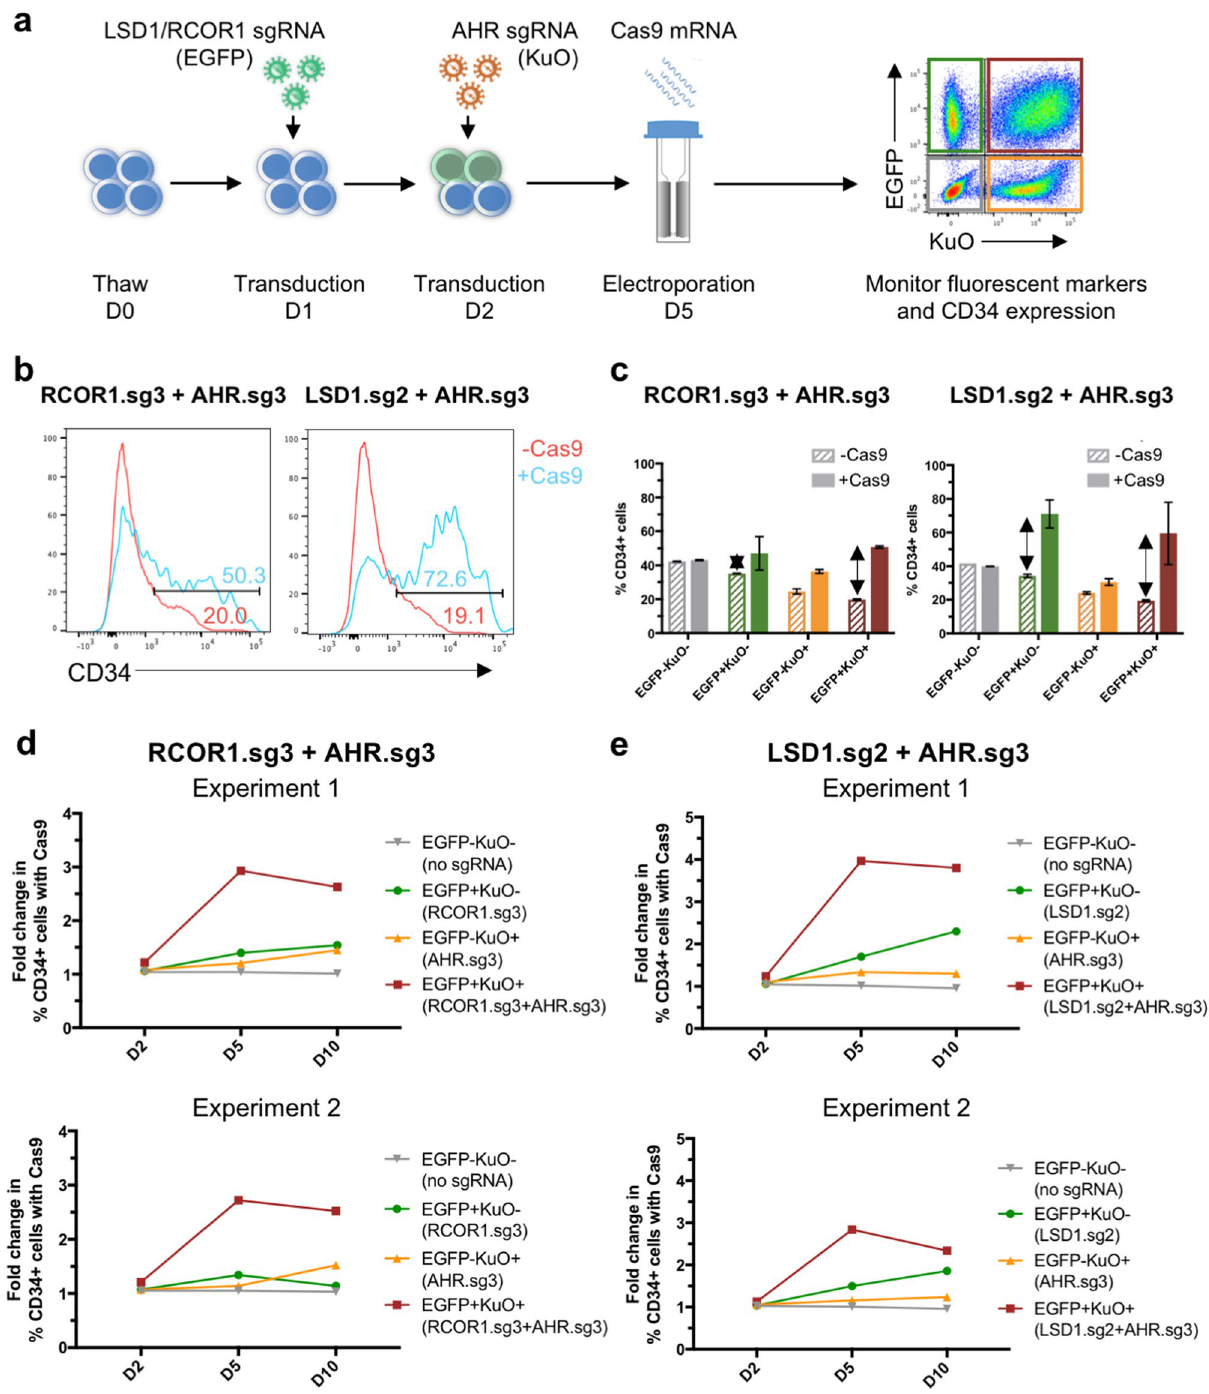
Figure 3. Combinatorial targeting of CoREST and AHR to propagate HSPCs ex vivo. ( a ) Schematic overview of experimental outline targeting LSD1 or RCOR1 and AHR. Thawed CD34 + cells were sequentially transduced on day 1 and day 2 with lentiviral sgRNAs targeting LSD1 or RCOR1 and AHR, containing EGFP or KuO, respectively. Cells were electroporated with Cas9 mRNA after 3 days in culture. Fluorescent marker and CD34 expression were monitored using flow cytometry. ( b ) Representative histograms showing the frequency of CD34 + cells in the double transduced (EGFP + KuO + ) population without (− Cas9) or with electroporation of Cas9 mRNA (+ Cas9) for sgRNA combinations RCOR1.sg3 and AHR.sg3, and LSD1.sg2 and AHR.sg3 at day 10 post-electroporation. ( c ) Frequency of CD34 + cells in the transduced populations using sgRNA combinations RCOR1.sg3 and AHR.sg3, and LSD1.sg2 and AHR.sg3, without (− Cas9) or with electroporation of Cas9 mRNA (+ Cas9) at day 10 post-electroporation. ( d , e ) The fold change in frequency of CD34 + cells with electroporation of Cas9 mRNA compared to only transduced cells (− Cas9) for sgRNA combinations RCOR1.sg3 and AHR.sg3, and LSD1.sg2 and AHR.sg3 at day 2, 5, and 10 (D2–10) post-electroporation in two independent